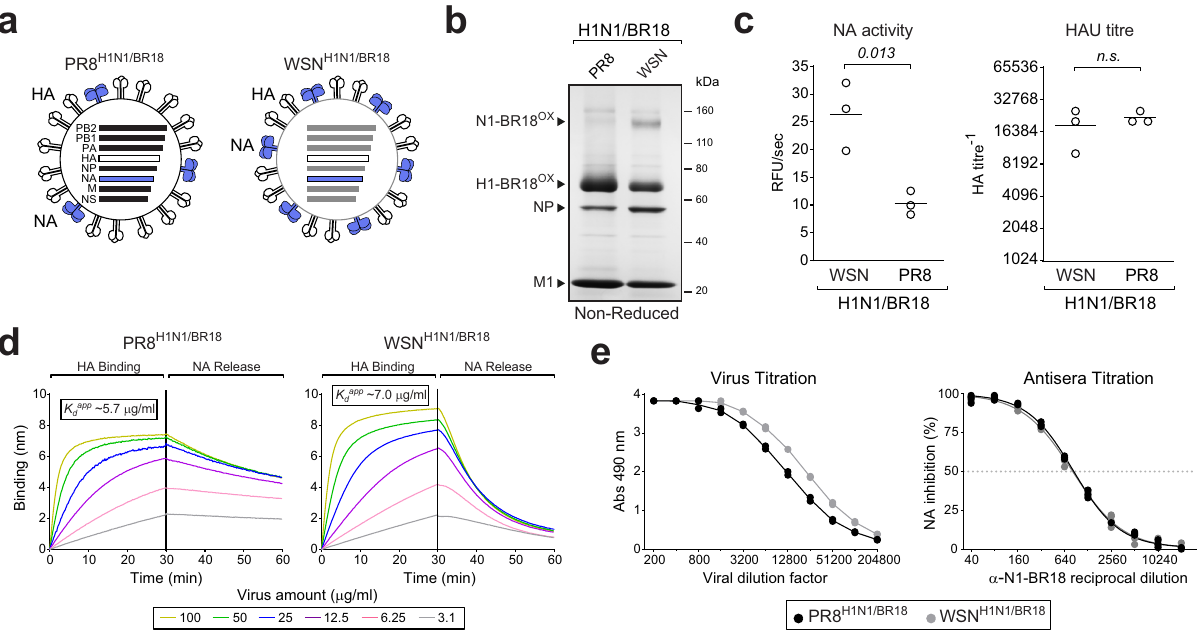
Fig. 2 Changes in viral NA content do not alter the ELLA results. a Diagram of the PR8 H1N1/BR18 and WSN H1N1/BR18 reassortant viruses. b Non- reduced Coomassie stained gel of puri fi ed PR8 H1N1/BR18 and WSN H1N1/BR18 viruses (~5 µg). Oxidised (OX) N1-BR18 and H1-BR18 are indicated with the viral proteins NP and M1. Original gel image is provided in Supplementary Fig. 5. c NA activities (left panel) and HAU titres (right panel) are shown for three independently puri fi ed virus batches with protein concentrations of 1 mg/ml. P values from an unpaired student T test, 95% CI, are displayed. n.s .- not signi fi cant. d Binding of puri fi ed PR8 H1N1/BR18 (left panel) and WSN H1N1/BR18 (right panel) virions to fetuin was measured by bio-layer interferometry. Curves were generated with equal densities of immobilised fetuin and the indicated puri fi ed virus protein concentrations. HA binding was measured in the presence of 10 µM zanamivir to inhibit NA activity and calculate the apparent dissociation constant ( K dapp ) for fetuin based on total viral protein concentrations. To follow NA-mediated release, biosensors with bound viruses were transferred to a well without zanamivir. e ELLA virus titrations for the PR8 H1N1/BR18 and WSN H1N1/BR18 viruses (left panel) are displayed with the ferret α -N1-BR18 antisera titration data (right panel) used to calculate the NAI titre. Virus titration data is from a single analysis run in duplicate. Antisera titration data is from two independent runs performed in duplicate. Source data for ( c – e ) are provided in the source data fi le.